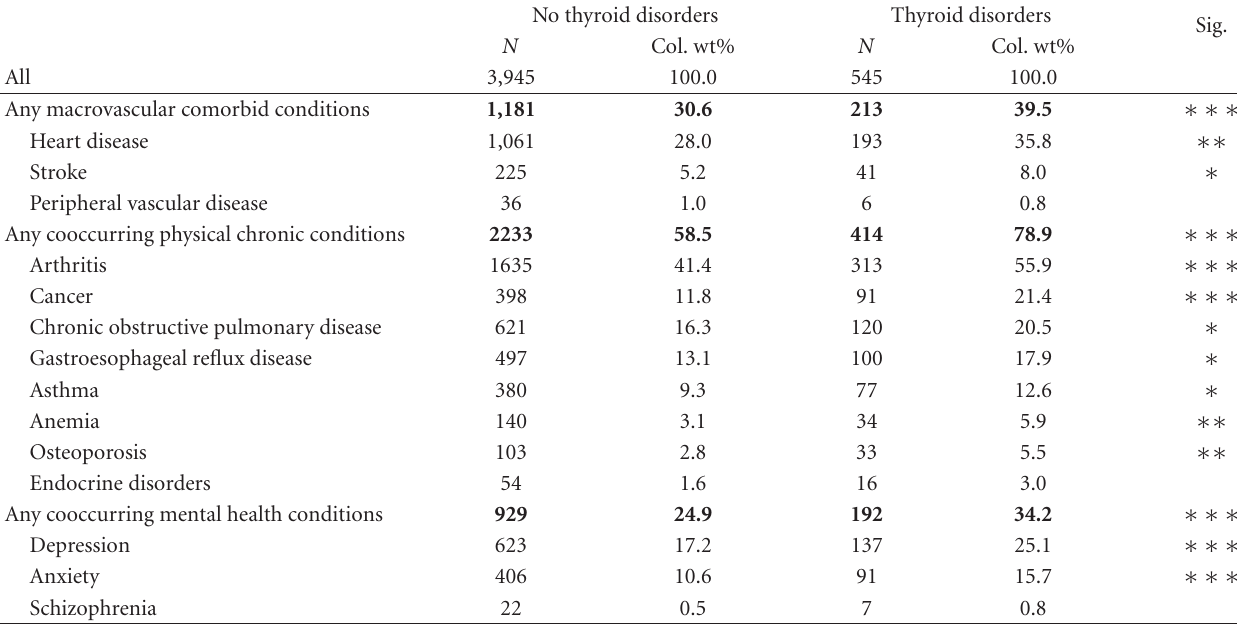
Table 2: Prevalence of co-occurring chronic conditions by the presence of thyroid disorders among individuals with diabetes from the Medical Expenditure Panel Survey, 2007 and